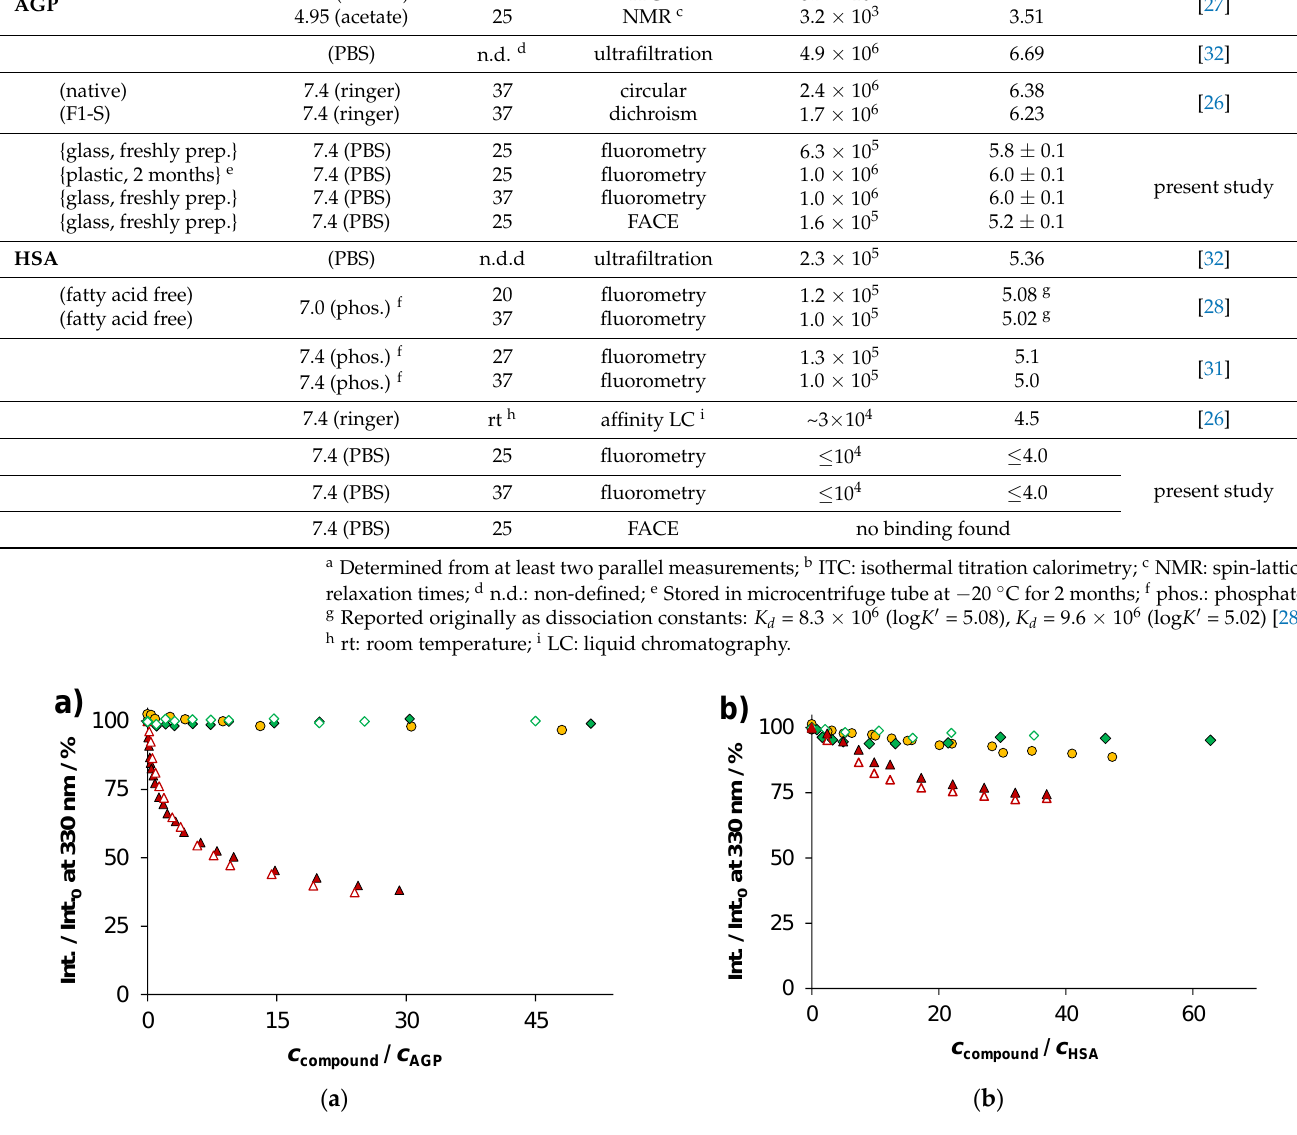
Figure 11. Comparison of the quenching effect of IMA ( ▲ ), FAVI ( ● ), h-MOLNU ( ◊ ) and MOLNU ( ♦ ) on the fluorescence of ( a ) AGP or ( b ) HSA at 25 °C; the quenching experiments with IMA were measured at 37 °C as well ( ∆ ) [ c AGP = 0.5 μM; c HSA = 1 μM; λ EX = 280 nm; λ EM = 330 nm; pH = 7.4 (PBS)]. The binding of IMA, h-MOLNU and FAVI to AGP was also investigated in dipyr- idamole (DIP) displacement experiments. Dipyridamole is a drug utilized for decreasing platelet aggregation and for coronary vasodilatation. It binds to AGP at one site with ex- tremely high affinity that is located in the hydrophobic pocket of the glycoprotein, and at least one additional low affinity site for DIP is assumed as well [58]. Dipyridamole is highly fluorescent in the visible range (λ max(EX) = 400 nm, λ max(EM) = 500 nm) and its steady-state flu- orescence spectrum was not very sensitive to the binding on AGP (Figure S15). On the other hand, fluorescence anisotropy is an excellent method to follow the protein binding of DIP. Briefly, fluorescence anisotropy experiments provide information on the size and shape of a fluorophore via measurement of the polarized emission of a solution [59]. AGP-bound DIP possesses much higher anisotropy due to the slower rotational diffusion of the protein in comparison to free DIP (own data: r bound ≈ 0.25; r free ≈ 0.003; at pH = 7.40 (PBS), 25 °C). As Figure 12 shows, a considerable amount of DIP is bound to AGP ( r = 0.14) under the applied conditions, and the anisotropy of the sample decreases by the addition of IMA in line with the increase of free and rapidly rotating fraction of DIP. It is noteworthy that h-MOLNU was not able to displace DIP from its binding pocket (Figure 12). The same experiment per- formed with FAVI is a good example to draw attention to the possible false interpretation of fluorescence anisotropy data where the hypothesized competitor itself (FAVI) displays fluorescence under the conditions used. A decrease in anisotropy is also observed here,